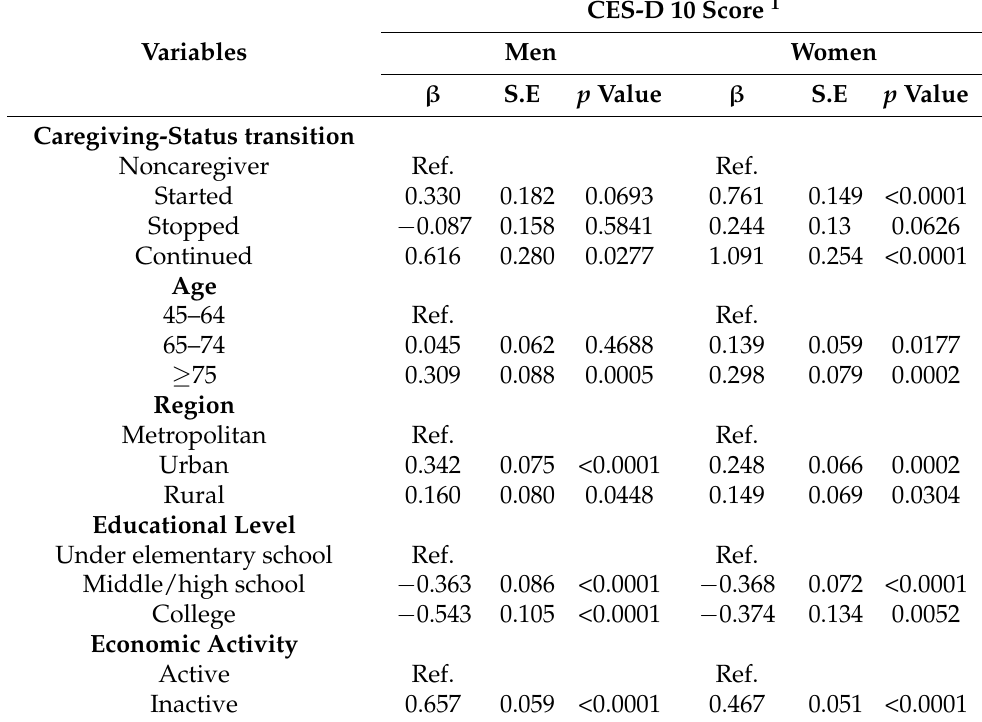
Table 2. Association between caregiving-status transitions and depressive symptoms: results of generalized estimating equation (GEE)